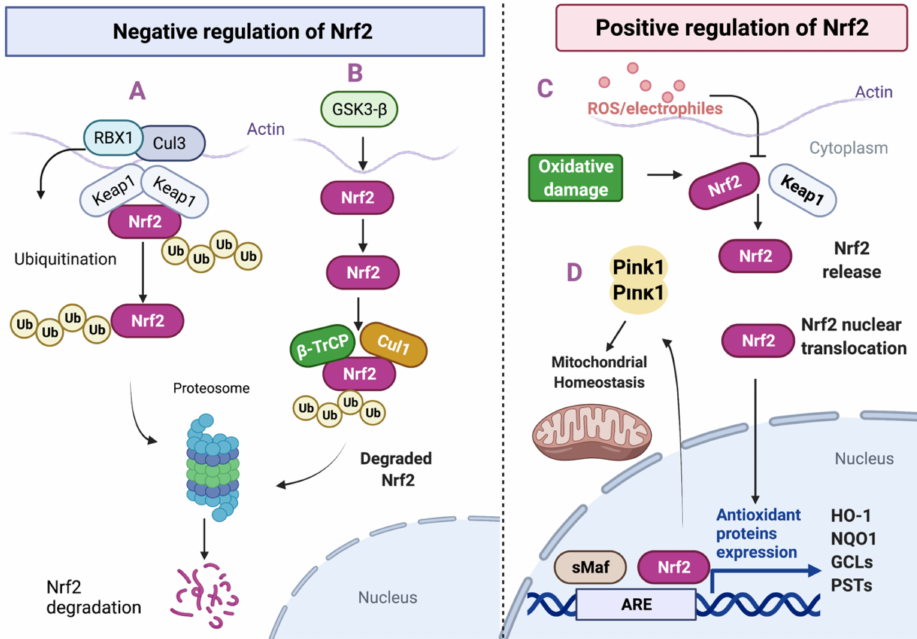
Figure 1. Regulation of the Nrf2 pathway in neuronal cells. ( A ) Negative regulation of Nrf2. Under basal conditions, Nrf2 expression is maintained at low levels through the proteasome activity. Nrf2 is sequestered by Keap1 in the cytosol leading to ubiquitination through the formation of the Keap1– Cul3-Rbx1 complex, which induces the Nrf2 proteasomal degradation. ( B ) Negative regulation of Nrf2 by GSK-3 β : Nrf2 can also be conducted to degradation by GSK-3 β . GSK-3 phosphorylates Nrf2 to create a recognition motif for the E3 ligase adapter β -TrCP. GSK-3/ β -TrCP leads to Keap1- independent ubiquitin-proteasome degradation of Nrf2. ( C ) Positive regulation of Nrf2: in the presence of high ROS levels, Nrf2 is released from Keap1 binding and is translocated to the nucleus and binds to ARE gene sequences, which allows for the activation of antioxidant genes such as HO-1 and NQO1. ( D ) Mitochondrial homeostasis: PINK1 expression is positively regulated by Nrf2 and promotes mitochondrial homeostasis through several mechanisms such as the removal of damaged